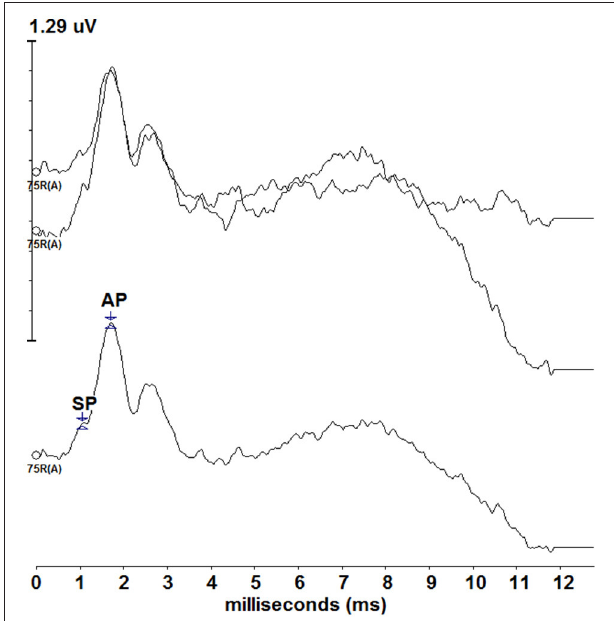
FIGURE 1 | Standard click ECochG responses from one of the participants (P9). Two traces (top) were recorded and averaged (bottom) depicting a typical ECochG response. The SP and AP are labeled on the averaged tracing, though standard ECochG data was not formally assessed during this